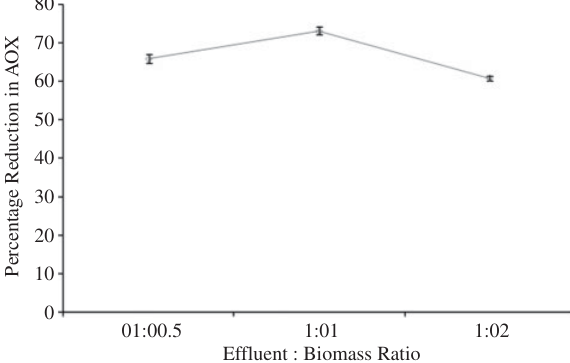
Fig. 5. Effect of surface washing of bacterial cell on the AOX reduction of pulp and paper mill effluent (n (cid:4) 5)